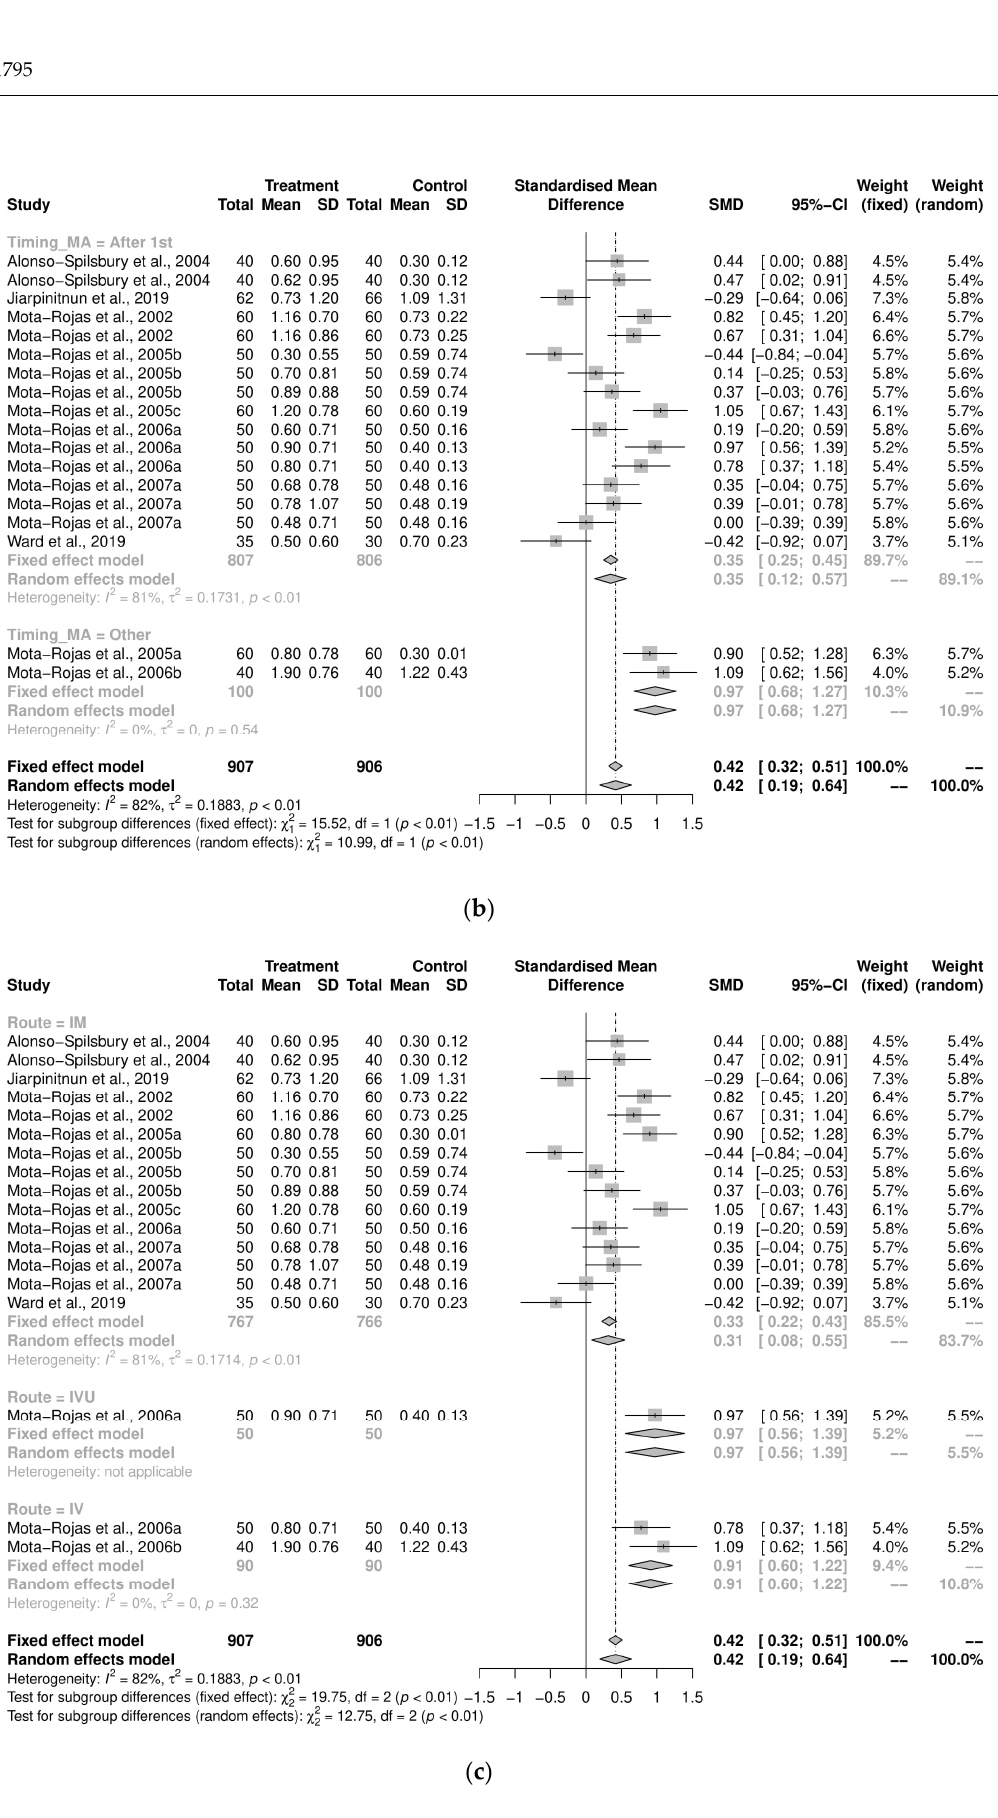
Figure 4. ( a ) Meta-analysis examining mean stillbirths in farrowing-assistance studies: sub-group analyses by dosage [30,37,39–45,51]. ( b ) Meta-analysis examining mean stillbirths in